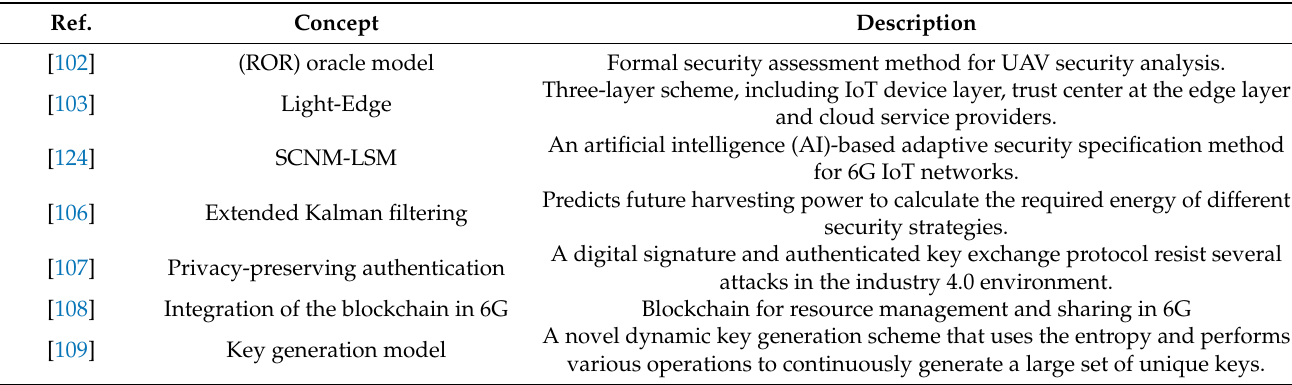
Table 3. 6G-Based Lightweight